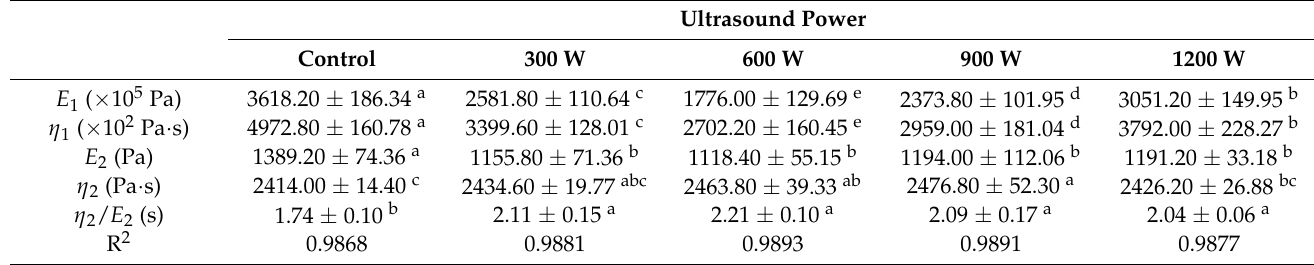
Table 2. Effects of different ultrasound power on creep parameters of WB. Ultrasound